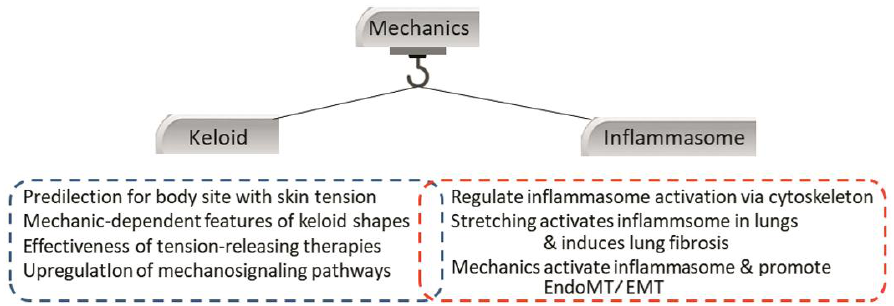
Figure 3. Mechanical stimuli may activate the NLRP3 inflammasome, thereby contributing to the fibrosis that leads to pathological scarring.